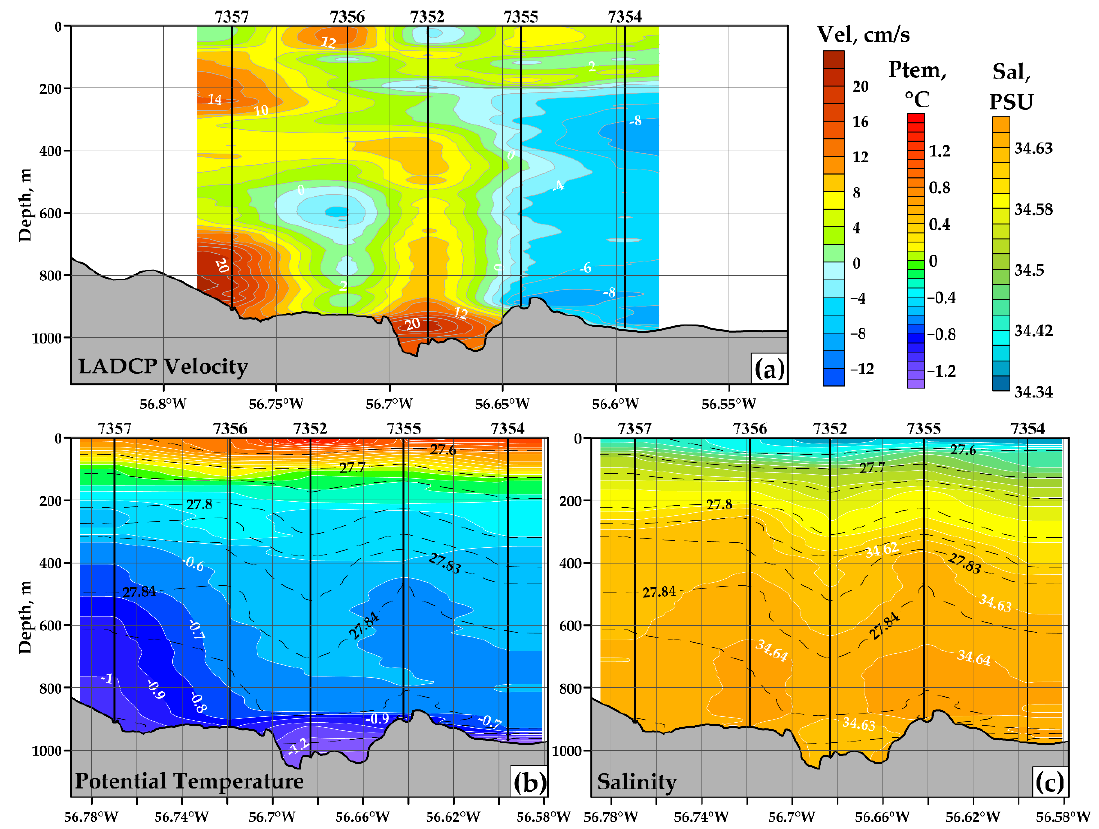
Figure 5. Structure of the deep overflow between the CB and EB of the strait: distribution of the ( a ) northeastern velocity (true direction is 45°) based on LADCP data, ( b ) potential temperature, and ( c ) salinity based on CTD data. Contours of potential density anomalies are shown with dashed black lines. Positions of stations are indicated with vertical solid lines together with the numbers of the stations.